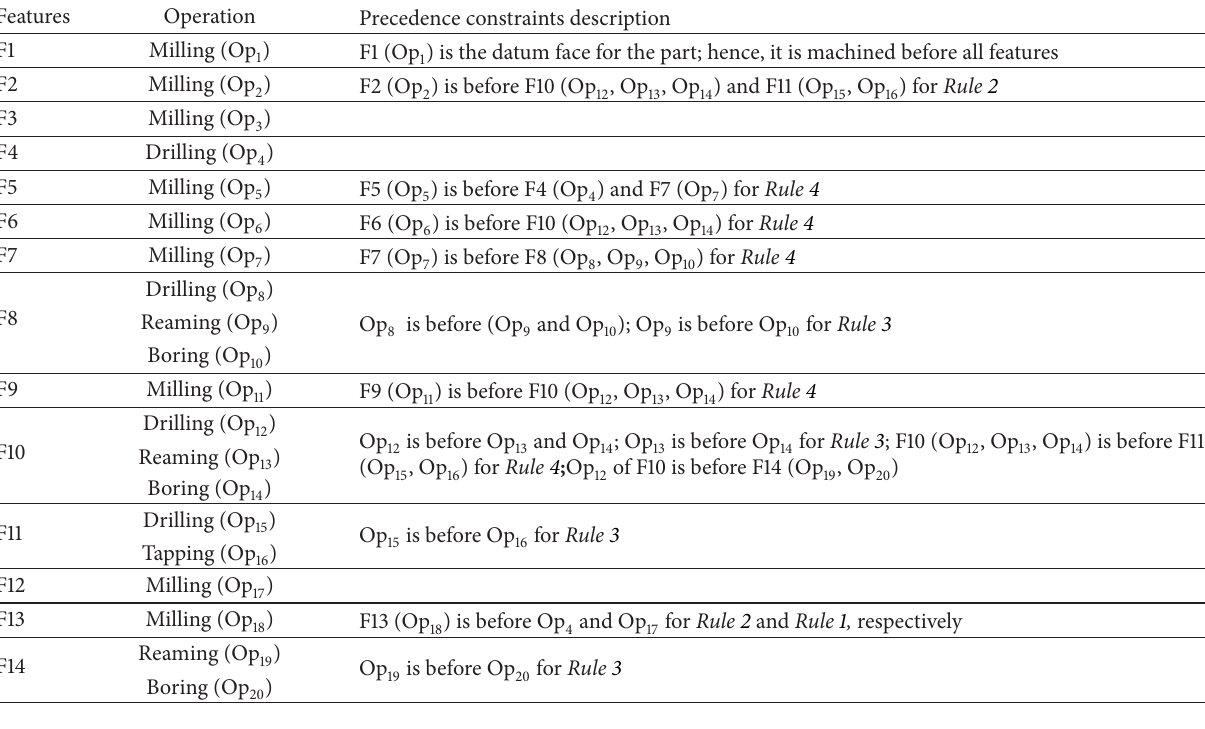
Table 9: Precedence relationship between features and operations.